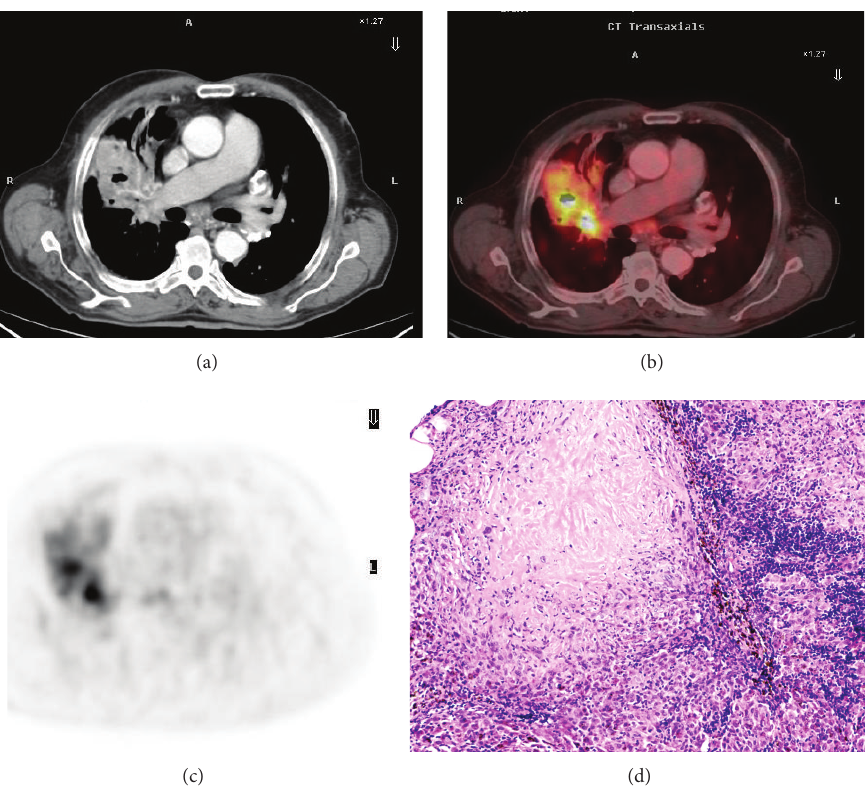
Figure 6: Images for a 62-year-old man with stage T2b and N1 NSCLC (epidermoid) in the right upper lobe. (a) CT image showing a lesion in the right upper lobe with adenopathy in space 7. (b) PET image showing 18 F-FDG uptake (maximum SUV 9). (c) PET/CT image showing 18 F-FDG uptake in the primary lesion and affected lymph node. (d) Histological analysis revealed the lymph node lesion not to be a tumor but rather hyperplastic anthracoid inflammation. Thus PET/CT provided a false-positive